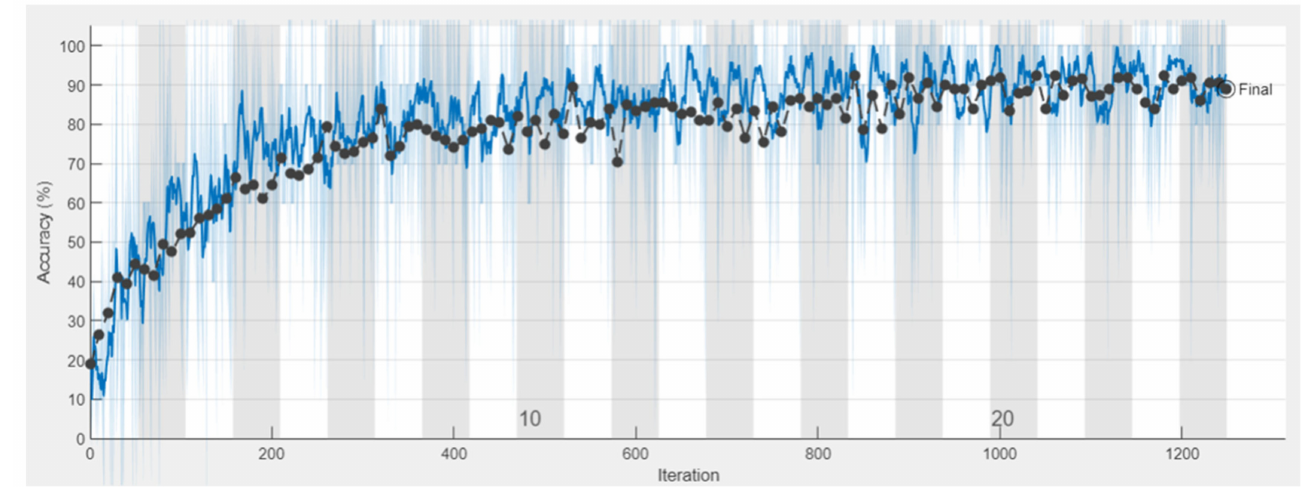
Figure 13. Training and validation accuracy progress for the mixed signal: training in light blue and in blue (smoothed), validation in black dashed.